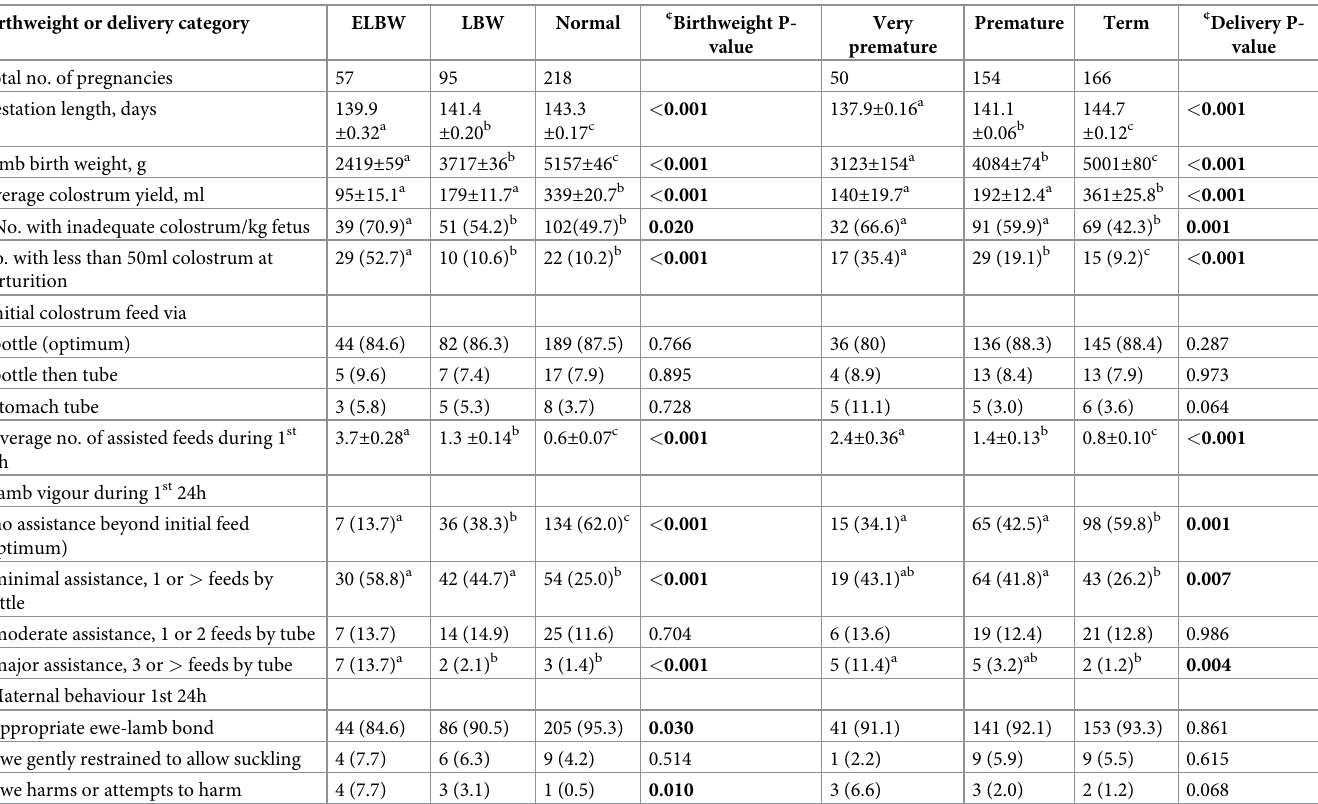
Table 4. Initial colostrum yield, lamb vigour and maternal behaviour during the first 24h after delivery in relation to birthweight and delivery categories. Birthweight or delivery